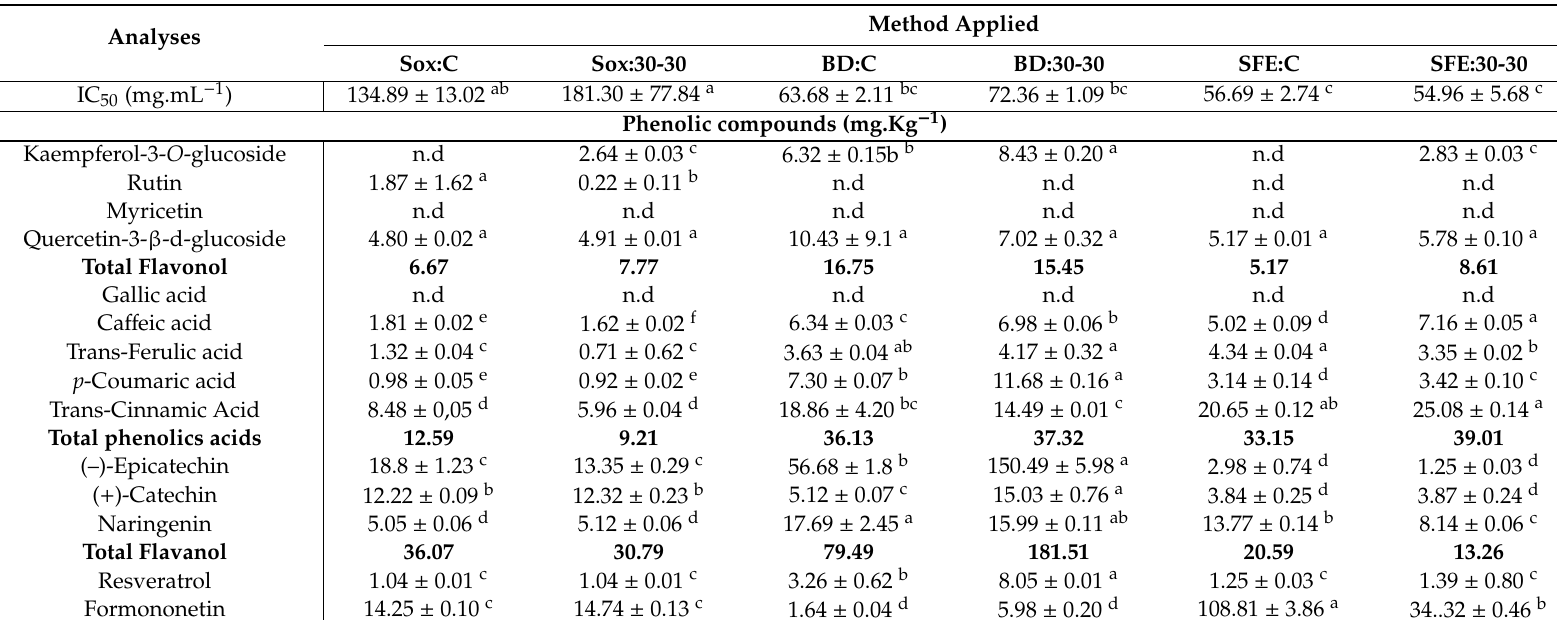
Table 4. Determination of antioxidant activity by DPPH (IC 50 ) and phenolic compounds (mg / kg) obtained extraction methods (Sox, BD, and SFE) at condition 30:30 and their respective control (C) (without